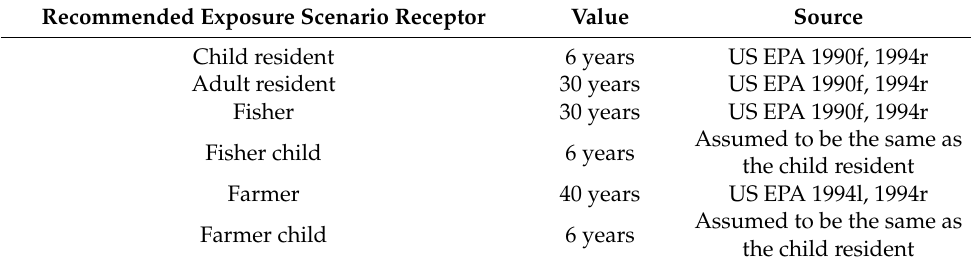
Table 6. Values of exposure